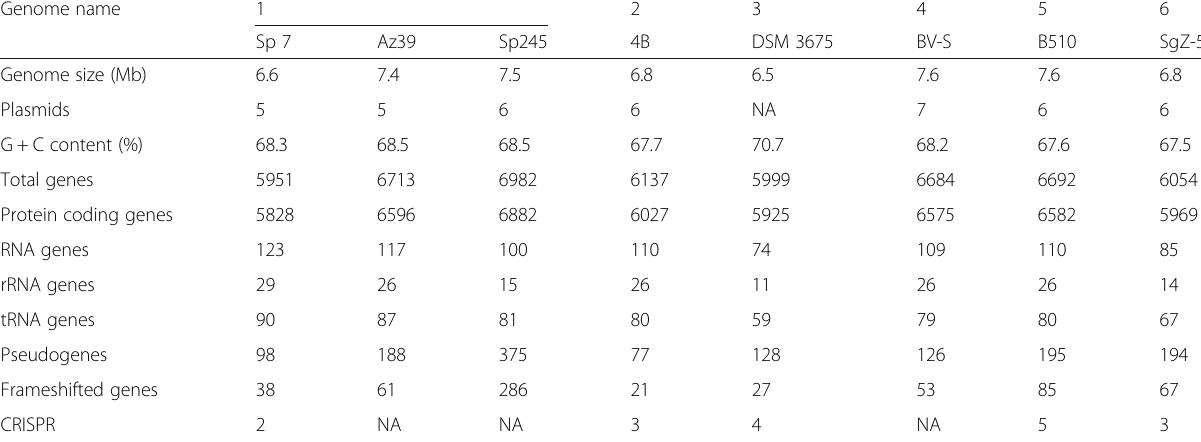
Table 6 Genome statistics comparison among characterized Azospirillum species